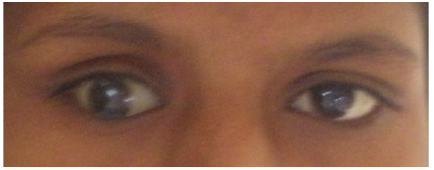
Figure 1: Left eye with an eye prosthesis.